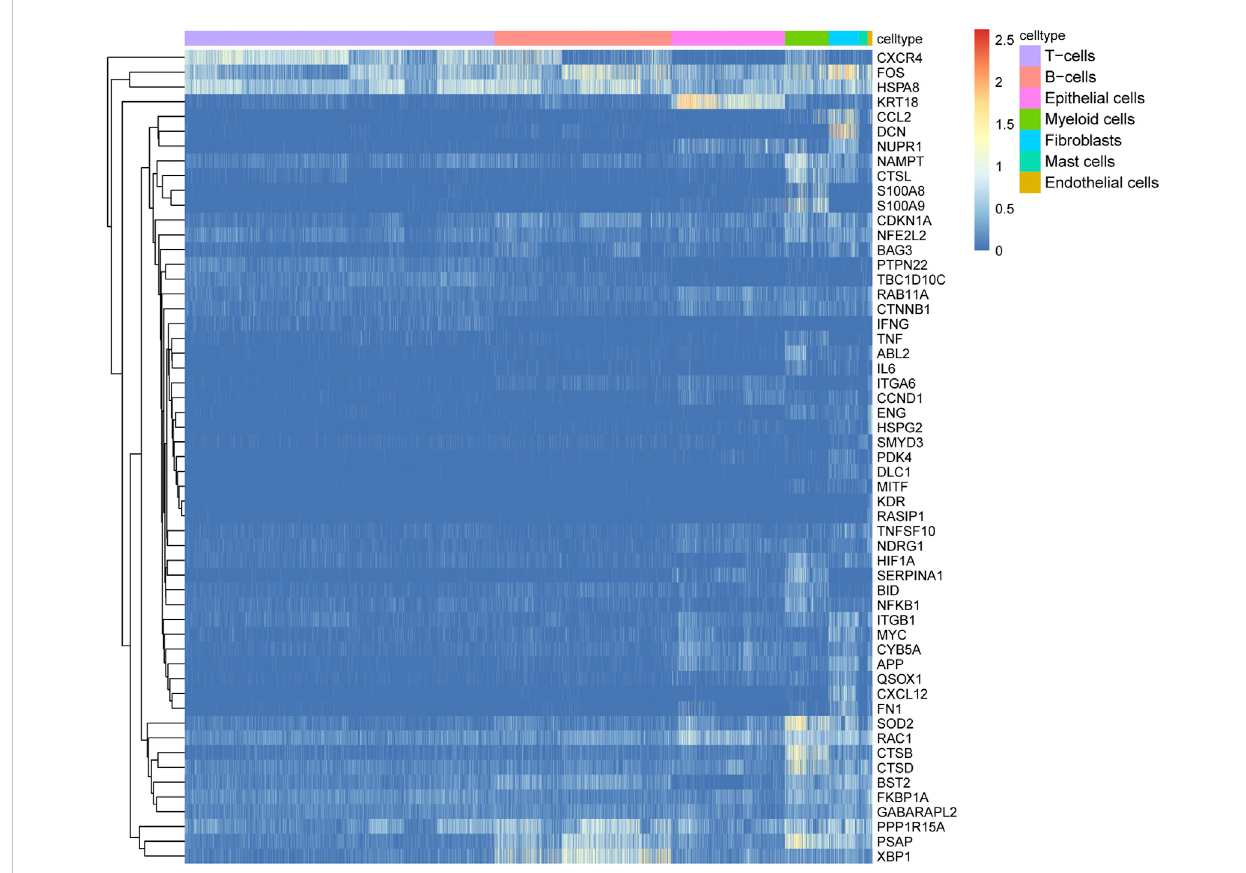
FIGURE 4 Expression heatmapof55autophagy-related genes(ARGs) amongthesevencell types.Blue-redintensitiesrepresenttheexpressionlevels ofARGs from low (blue) to high